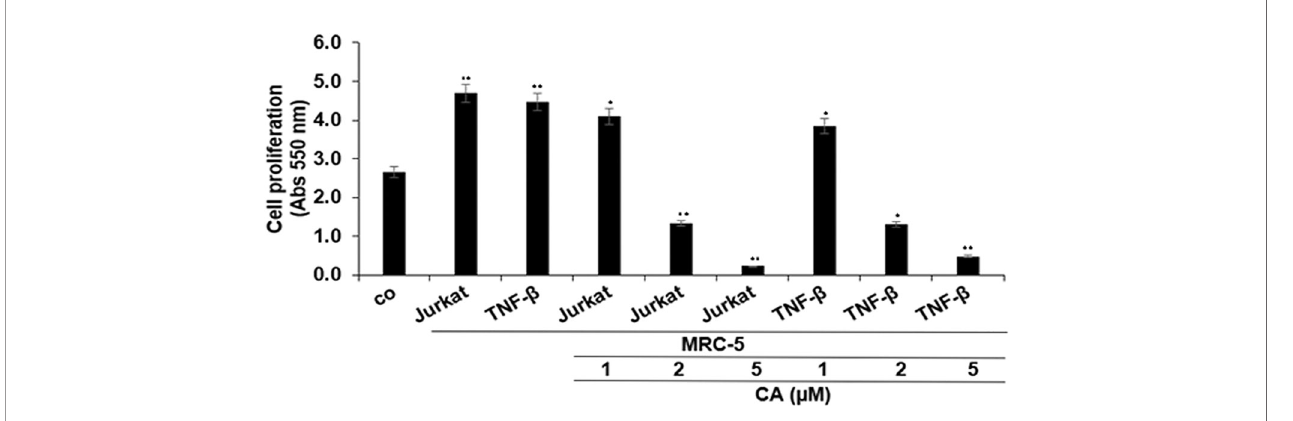
FIGURE 2 | Effects of Calebin A on multicellular proin fl ammatory TME-induced HCT116 cell proliferation in 3D-alginate culture. Serum-starved cultures of HCT116 cells in 3D-alginate cultures alone (basal control = co) or co-cultured with fi broblasts and T-lymphocytes (proin fl ammatory multicellular TME) or co-cultured with fi broblasts and TNF- b (10 ng/ml) (TNF- b -TME) were either left untreated or treated with various concentrations of Calebin A (CA) (1, 2, and 5 µM) for 10 days in alginate cultures, and cell viability and proliferation were evaluated with the MTT assay, as described in Materials and Methods . All assays were performed with at least three independent replicates. * p < 0.05 and ** p < 0.01 indicate a signi fi cant difference compared to the control